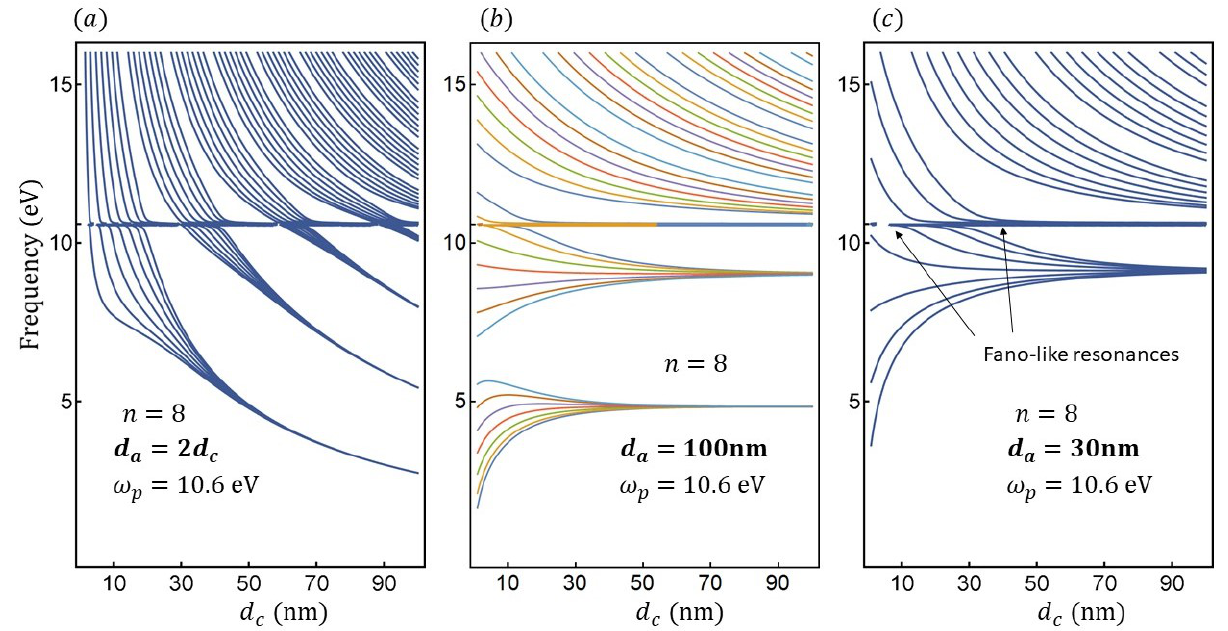
Figure 9. Subbands of a dielectric / ( aluminum / dielectric ) n superlattice and different relationships for the dielectric and conductor widths. In subfigure ( a ), both widths, d a and d c , grow but d a is always twice larger than d c ; in subfigure ( b ), d a is kept fixed equal to 100 nm and d c < d a is smaller varying from 0.01 to 100 nm. In subfigure ( c ), d a is kept fixed equal to 30 nm, d c smaller and larger than d a , varies between 0.01 nm and 100 nm. Fano-like resonances occur at ω = ω p , see the